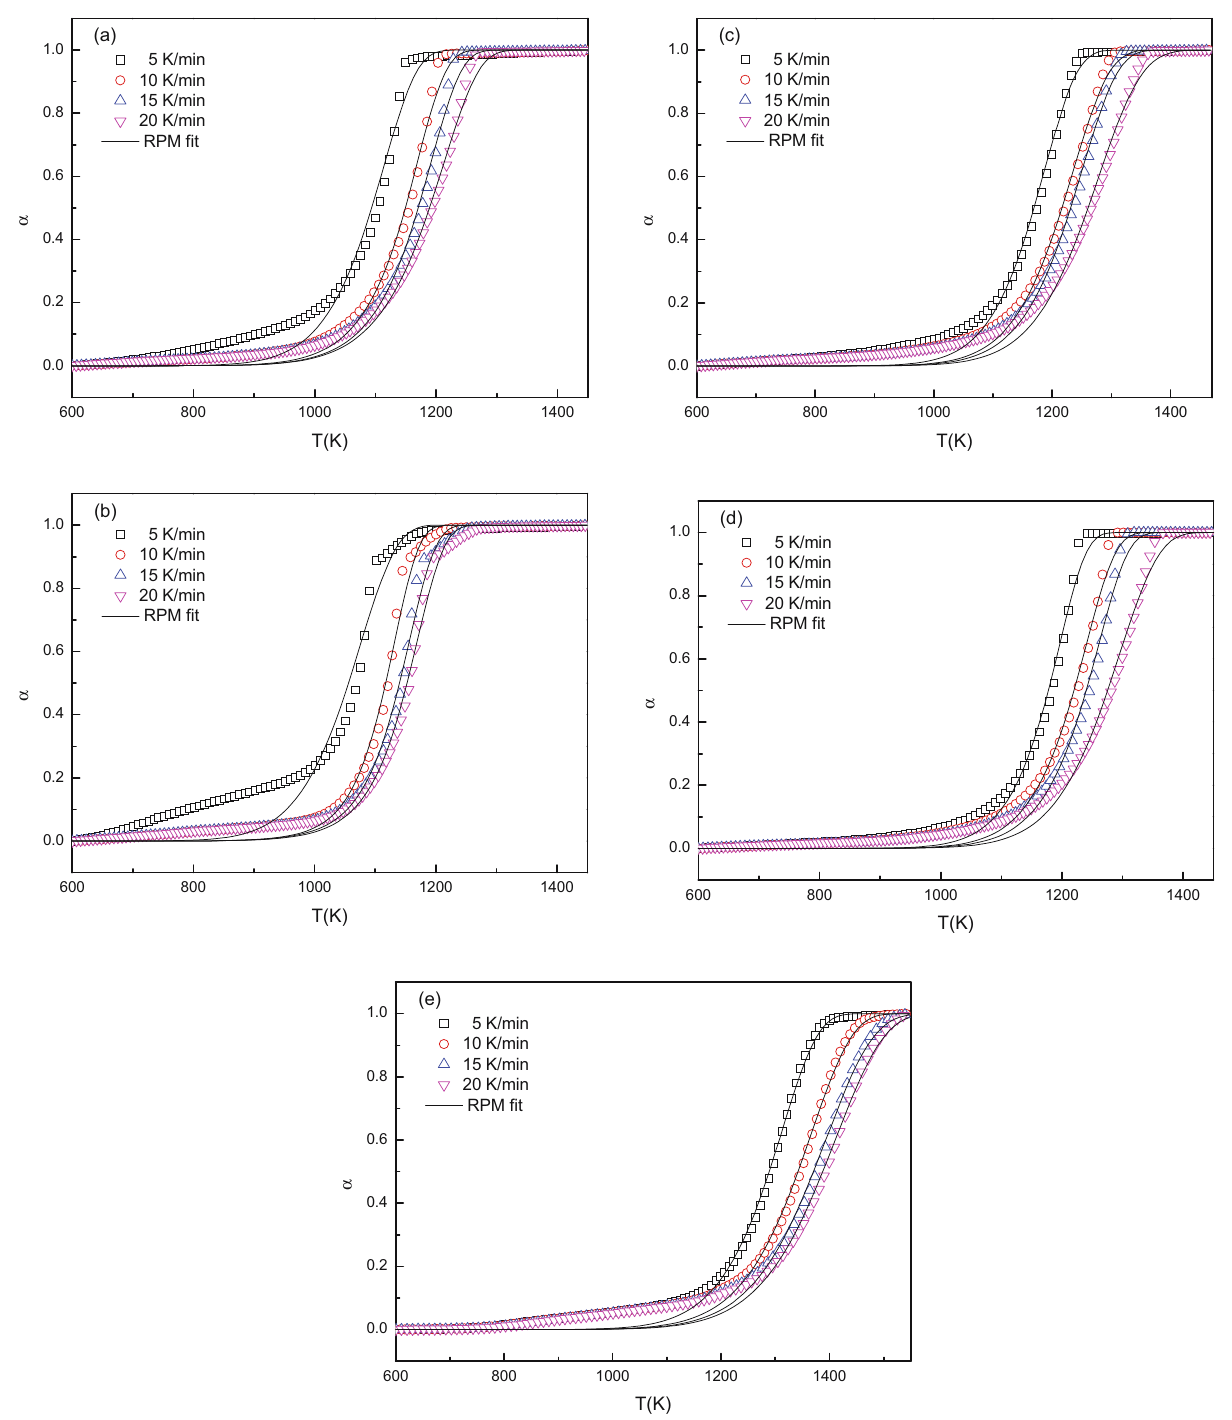
Figure 5: Experimental and fi tted conversions for di ff erent biochars and anthracite during gasi fi cation with CO 2 : ( a ) SD - char; ( b ) WS - char; ( c ) RH - char; ( d ) BB - char and ( e )